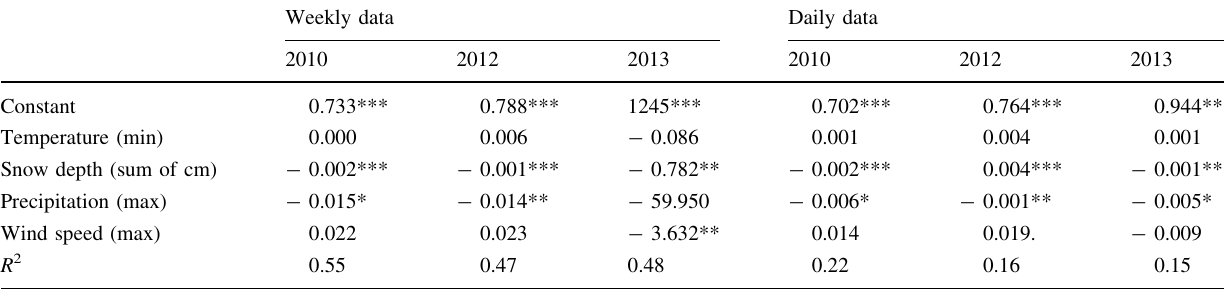
Table 5 Regression models for